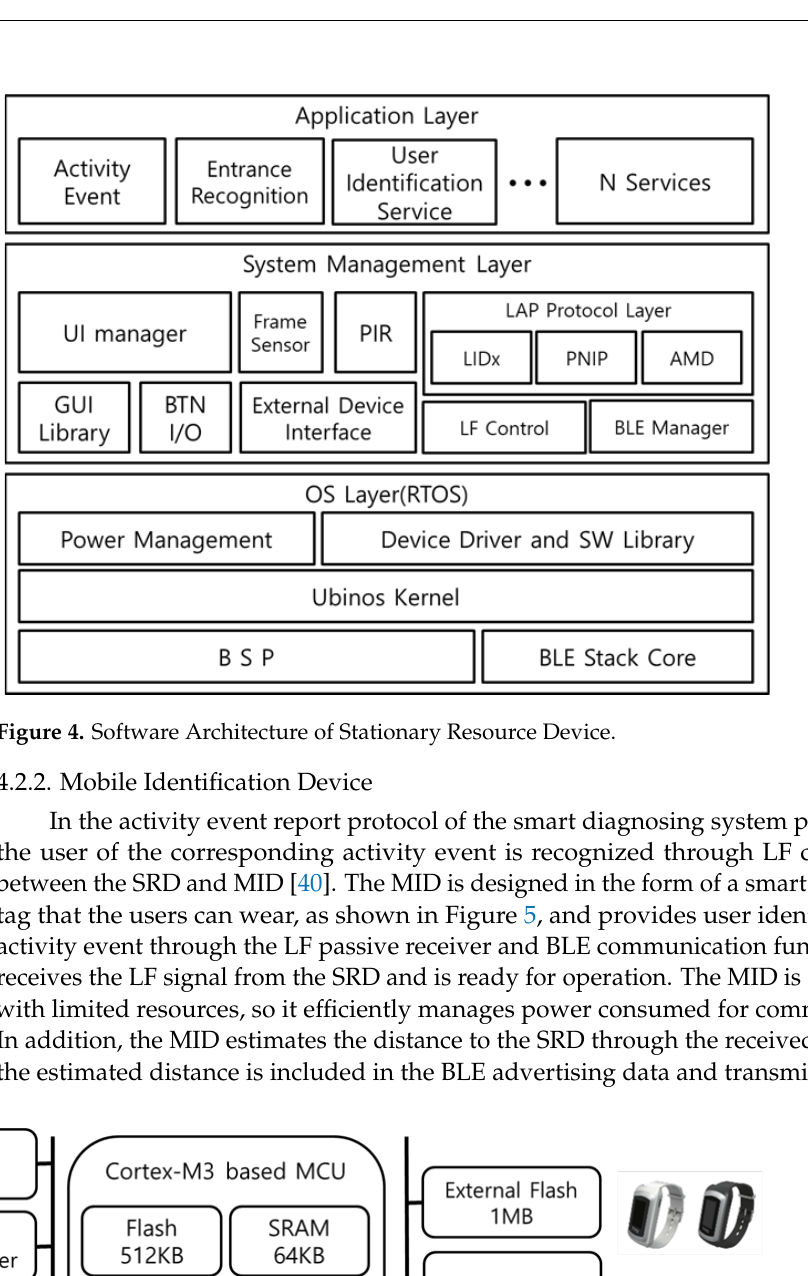
Figure 6. Cell Management and Location Registration Protocol. The SRD transmits its ID and location registration request to the nearest LAN through BLE advertising. The LAN receiving the SRD’s request checks whether the corre- sponding SRD exists in its cell through the location server, which estimates the location information of the RD and MID by collecting the BLE beacon information received from the LAN. The SRD registered through the location information is managed through the LAN’s location management table. Thereafter, the SRD maintains the BLE connection with the LAN and transmits the event information quickly. The LAN reports the location information of the registered SRD to the location server at each fixed update period and configures the overall location recognition system; it also periodically communicates with the SRD to check and manage connectivity.